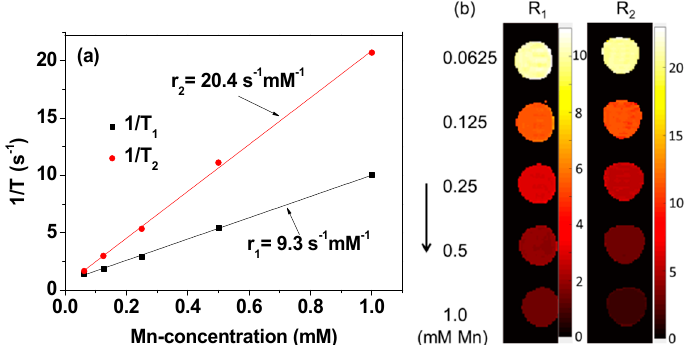
Figure 8. ( a ) 1/T 1 and 1/T 2 plots versus the Mn-concentration. The r 1 and r 2 values were estimated from the corresponding slopes, respectively. ( b ) Dose-dependent contrast enhancements in R 1 and R 2 map images.